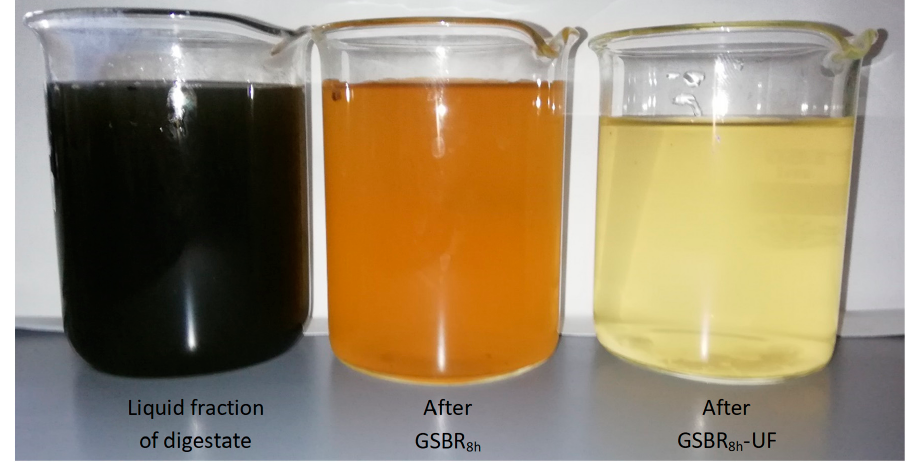
Figure 6. Effluents after particular stages of the treatment. Table 2. Results of membrane filtration and treatment in GSBR 8h -UF system (repetitions from 2 measurements).